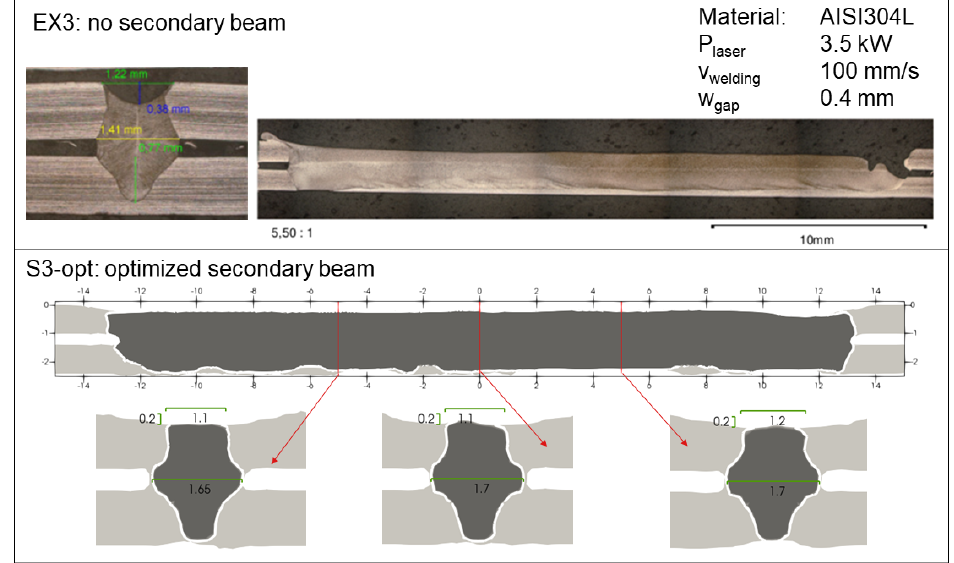
Figure 10. Longitudinal and cross-sections of simulation S3-opt, where a secondary laser beam was added to the conditions of EX3 and iteratively optimized. All measurements in